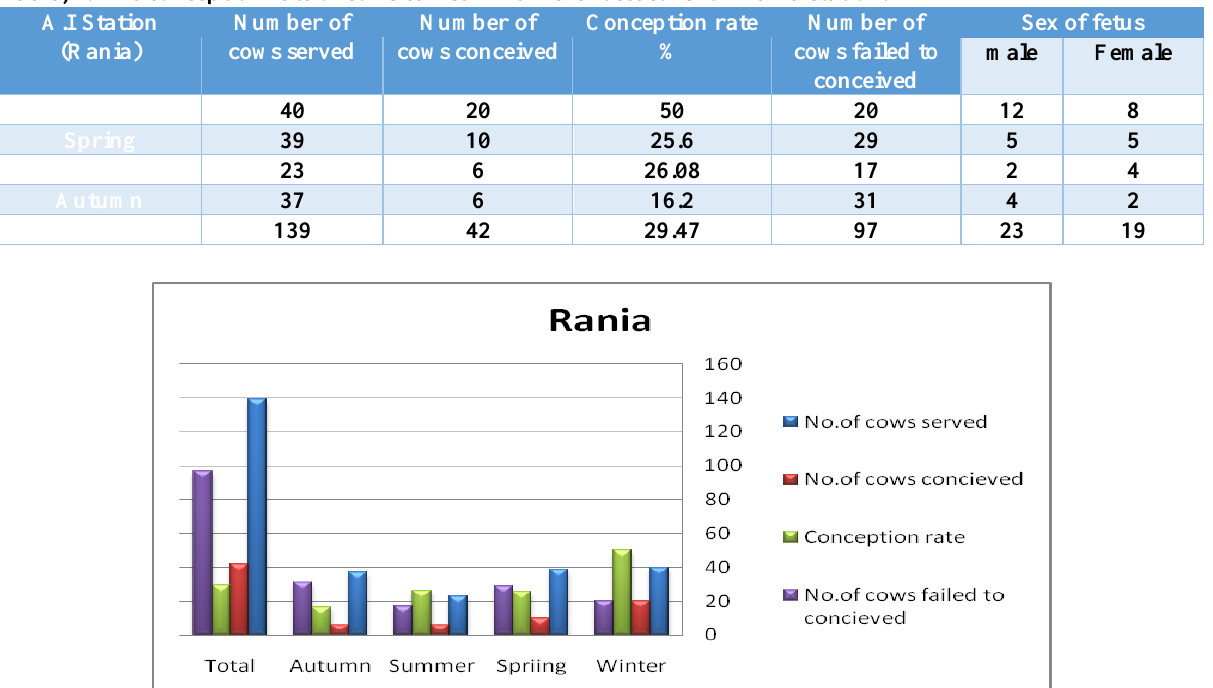
Figure, 3: The conception rate of cows and sex of calf in different seasons for Sharazoor station Table, 4: The conception rate of cows calf sex in different seasons for Rania station.